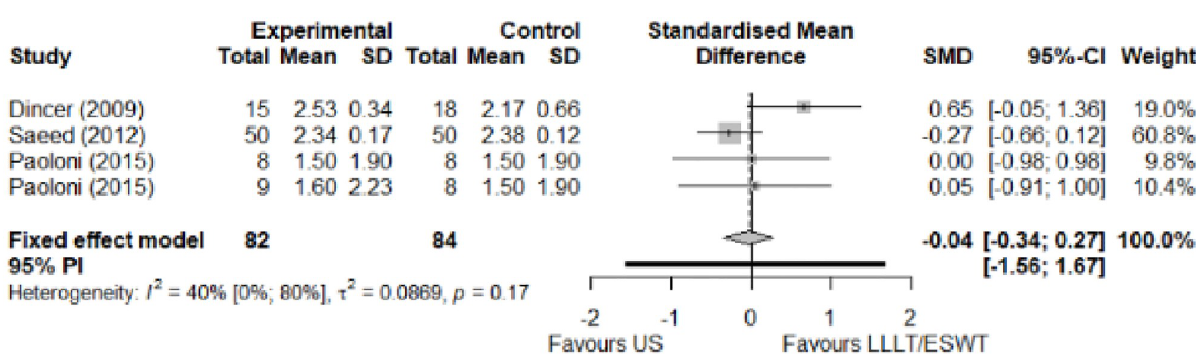
Fig 22. Analysis—Comparison between electrophysical modalities (functional status).